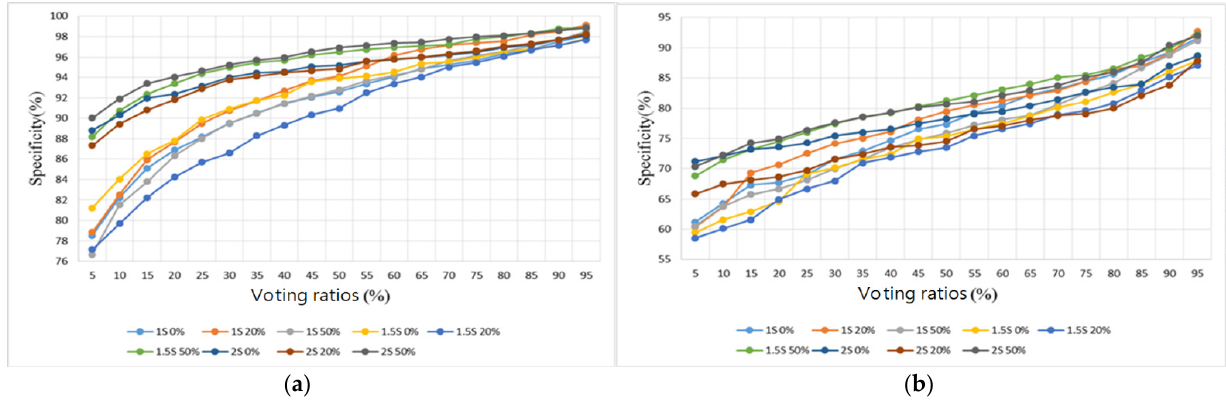
Figure 18. Heart sound classification results: Specificity. ( a ) Testing samples. ( b ) Noisy samples.